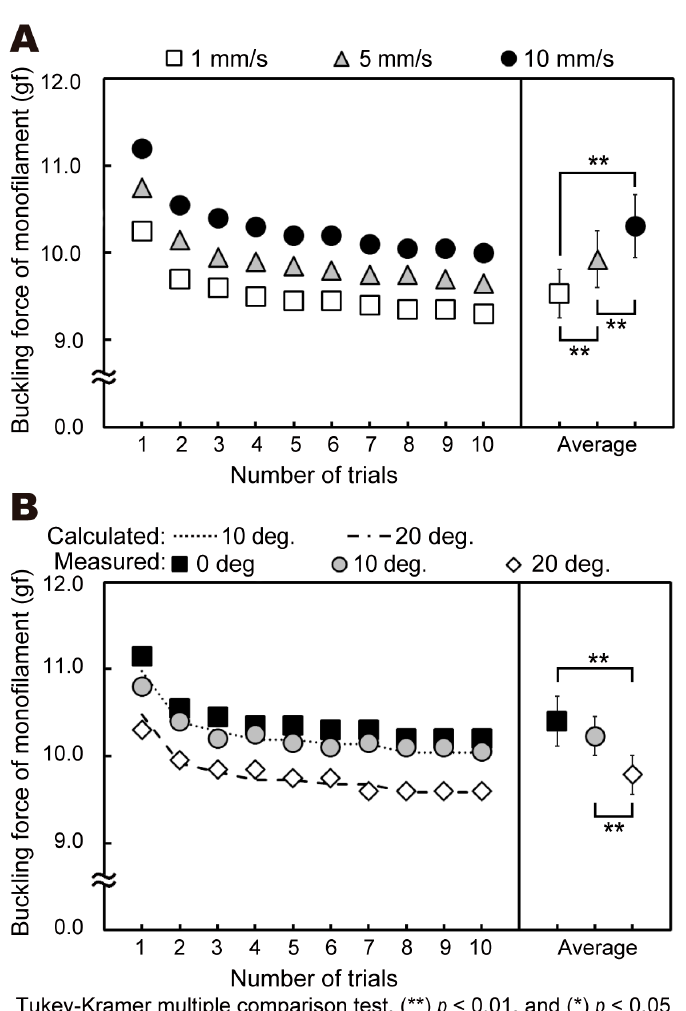
Figure 4. Experimental buckling force results for different operational scenarios under automated operation using the multi-use monofilament: ( A ) positioning stage velocities of 1, 5, and 10 mm/s; ( B ) monofilament contact angles of 0°, 10°, and 20°.